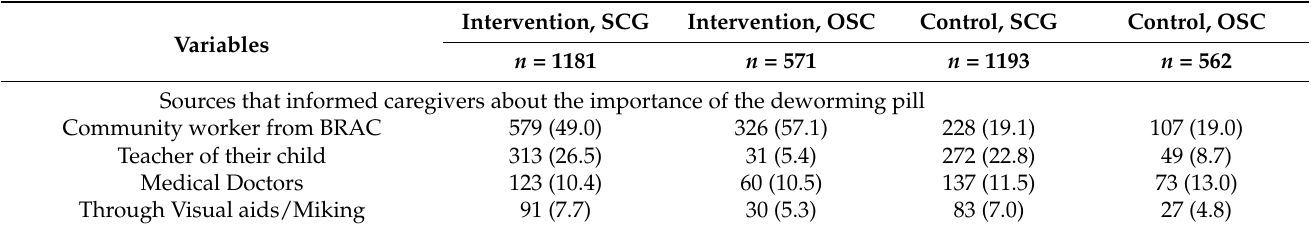
Table 4. Caregiver’s knowledge about deworming project